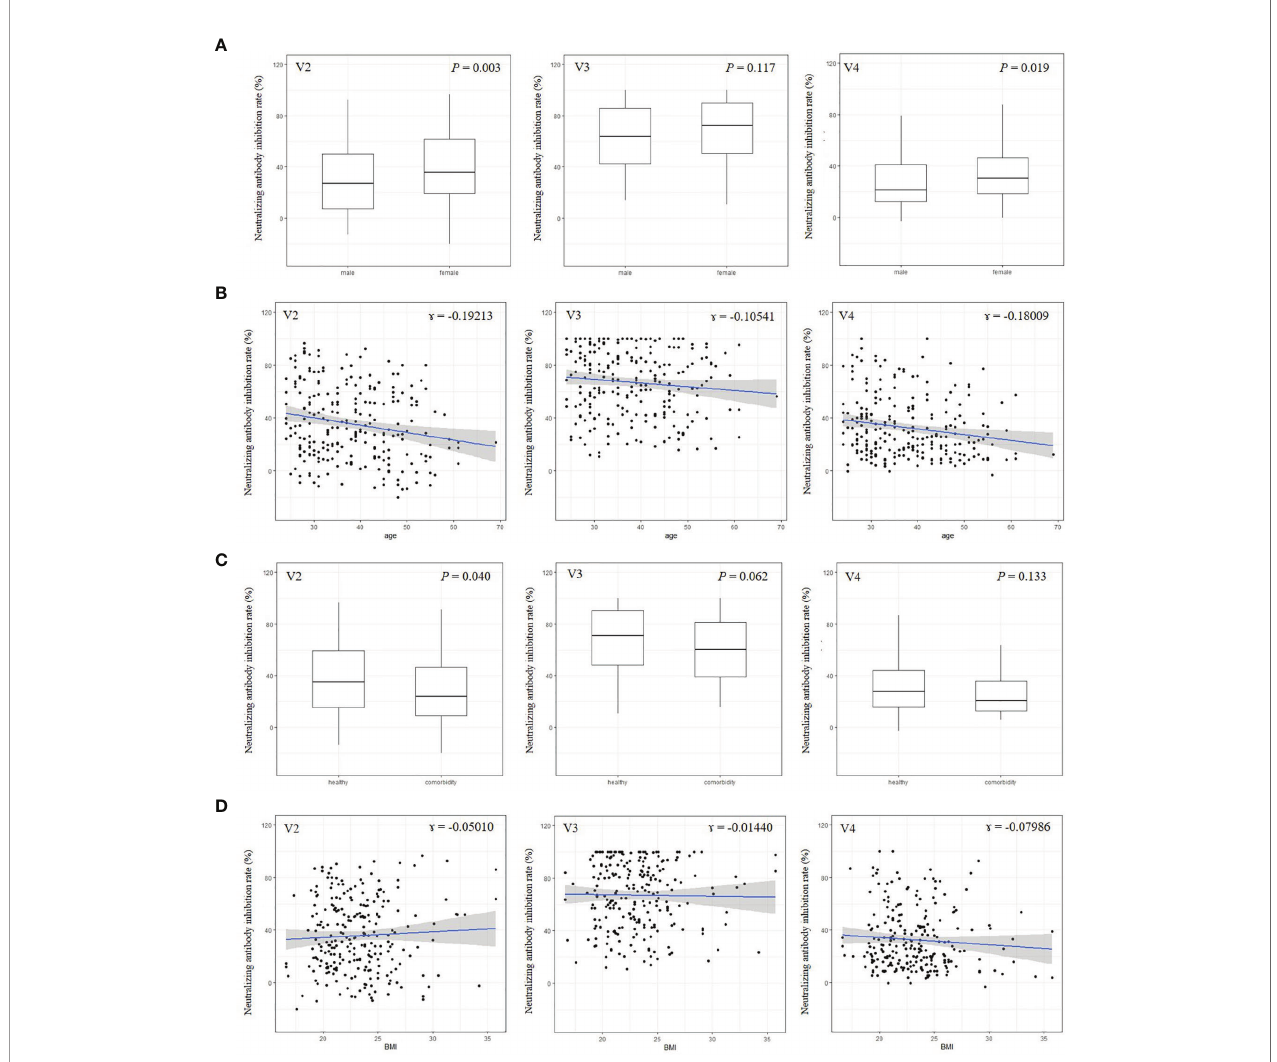
FIGURE 3 | Neutralizing antibody by sex (A) , age (B) , comorbidity (C) , and body mass index (D) .This is an antibody titer analyzed at visit 2 (4 weeks after 1 st vaccination), visit 3 (3 months after 2 nd vaccination), and visit 4 (6 months after 2 nd vaccination). BMI, body mass